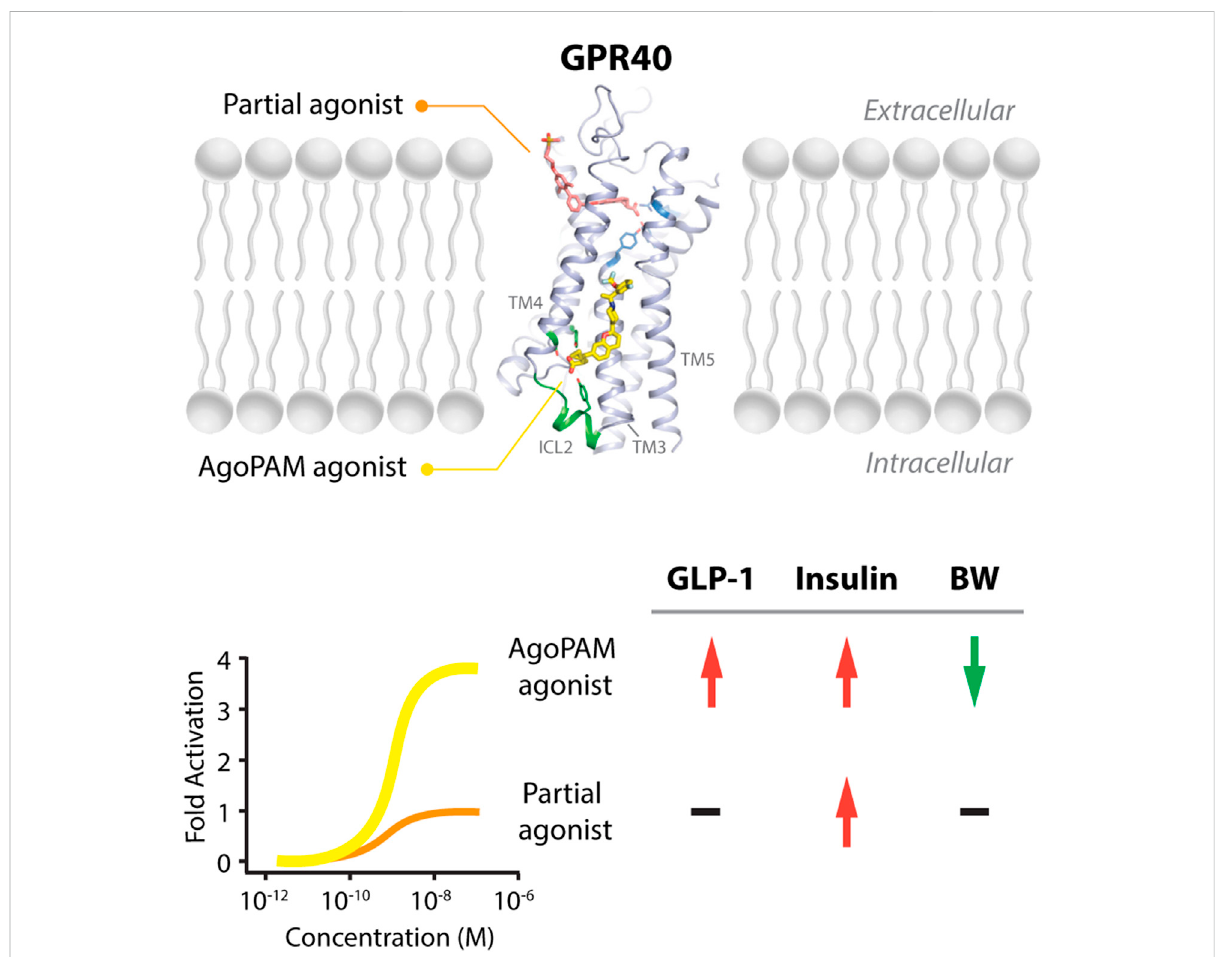
FIGURE 1 Binding sites of partial and AgoPAM agonists to GPR40 and their differential downstream effects. GPR40 partial agonists, including MK-8666 and TAK-875, bind to the area close to the extracellular surface between transmembrane (TM) helix 3 and transmembrane helix 4. In contrast, GPR40AgoPAMagonistssuchasAP8bindstoanareaoutsideoftheseventransmembrane-helicalbundle,inawell-de fi neddeeppocketformedby transmembrane helices TM3, TM4, TM5 and the second intracellular loop (ICL2) (Adapted from PDB: 5TZY, Lu et al., 2017). In cells expressing low levels of GPR40, AgoPAM agonists induce robust inositol monophosphate (IP1) accumulation, around 3-4-fold higher than partial agonists. In the in vivo condition, GPR40 AgoPAM agonists increase GLP-1 and insulin secretion and decrease body weight, while partial agonists only increase insulin